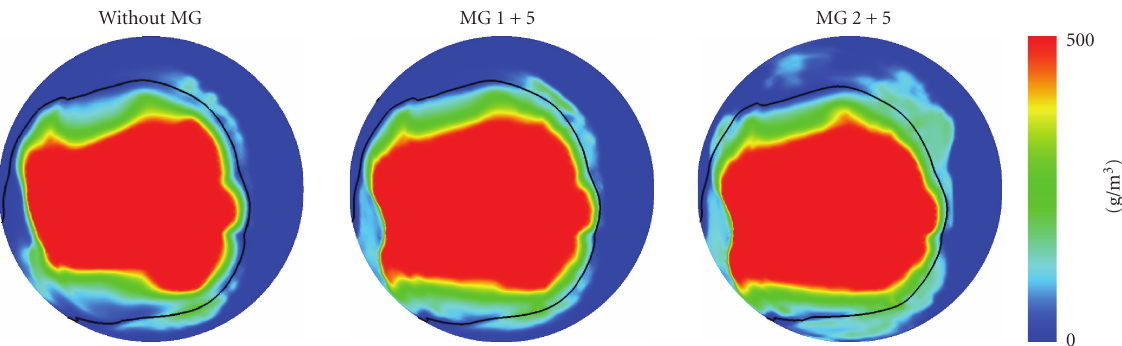
Figure 8: Iso-surface of flame front (black line) and NOx distribution at CA = 18 deg